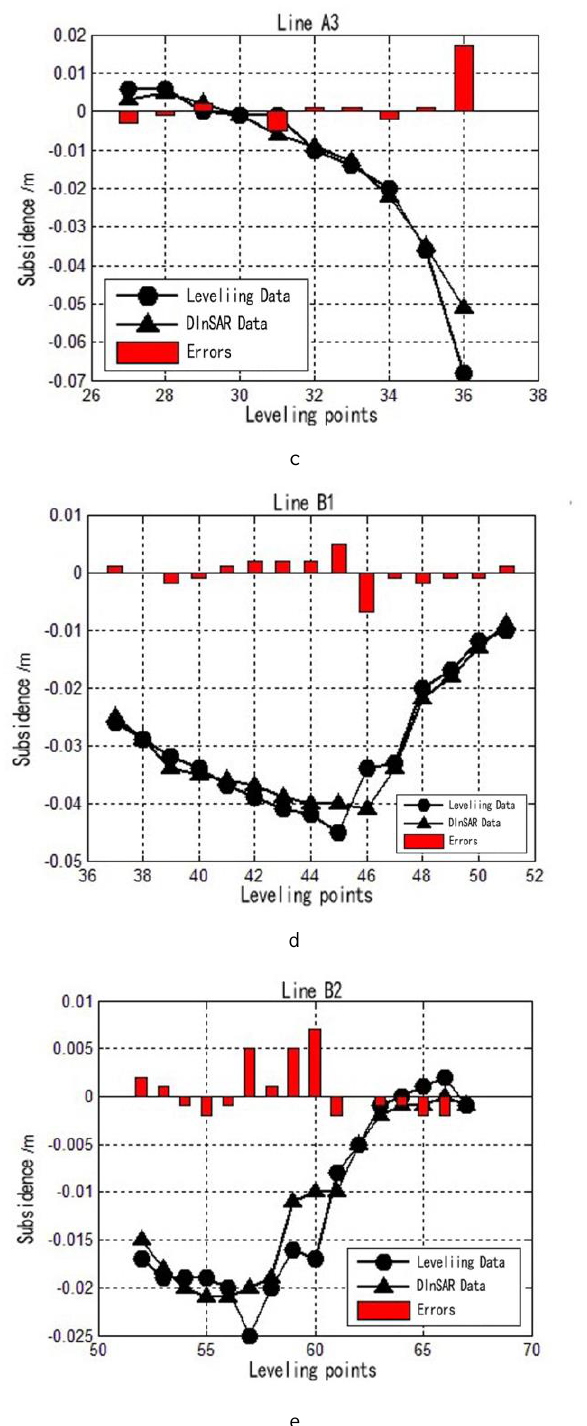
Figure 5. Comparison between leveling data and DInSAR